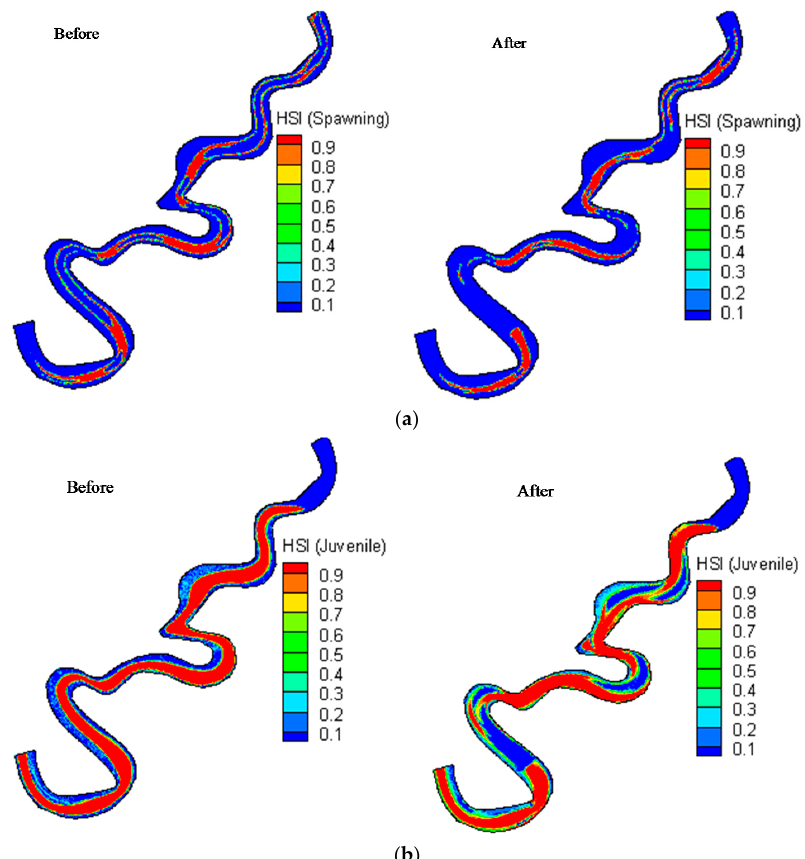
Figure 8. Before the HFE and after the HFE habitat suitability index distribution for spawning ( a ) and juvenile ( b ) rainbow trout.